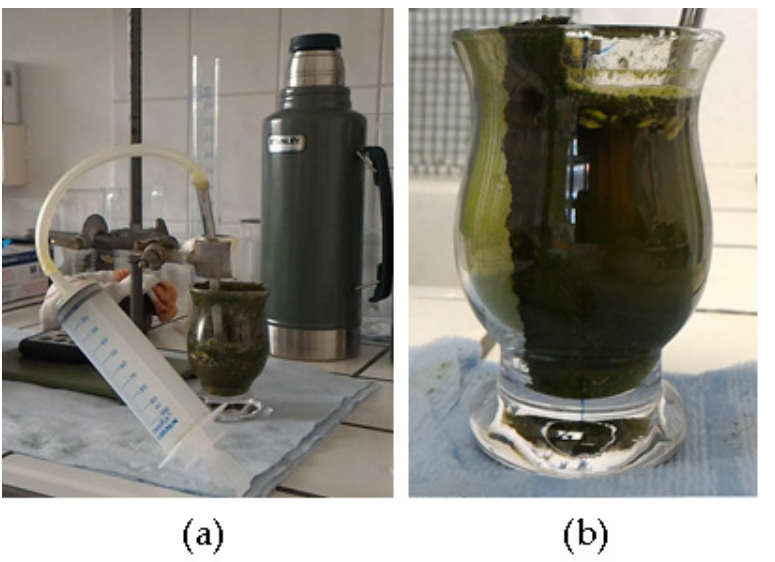
Figure 2. Apparatus for traditional consecutive infusions: ( a )—whole laboratory setting; ( b )—consecutive infusion happening.